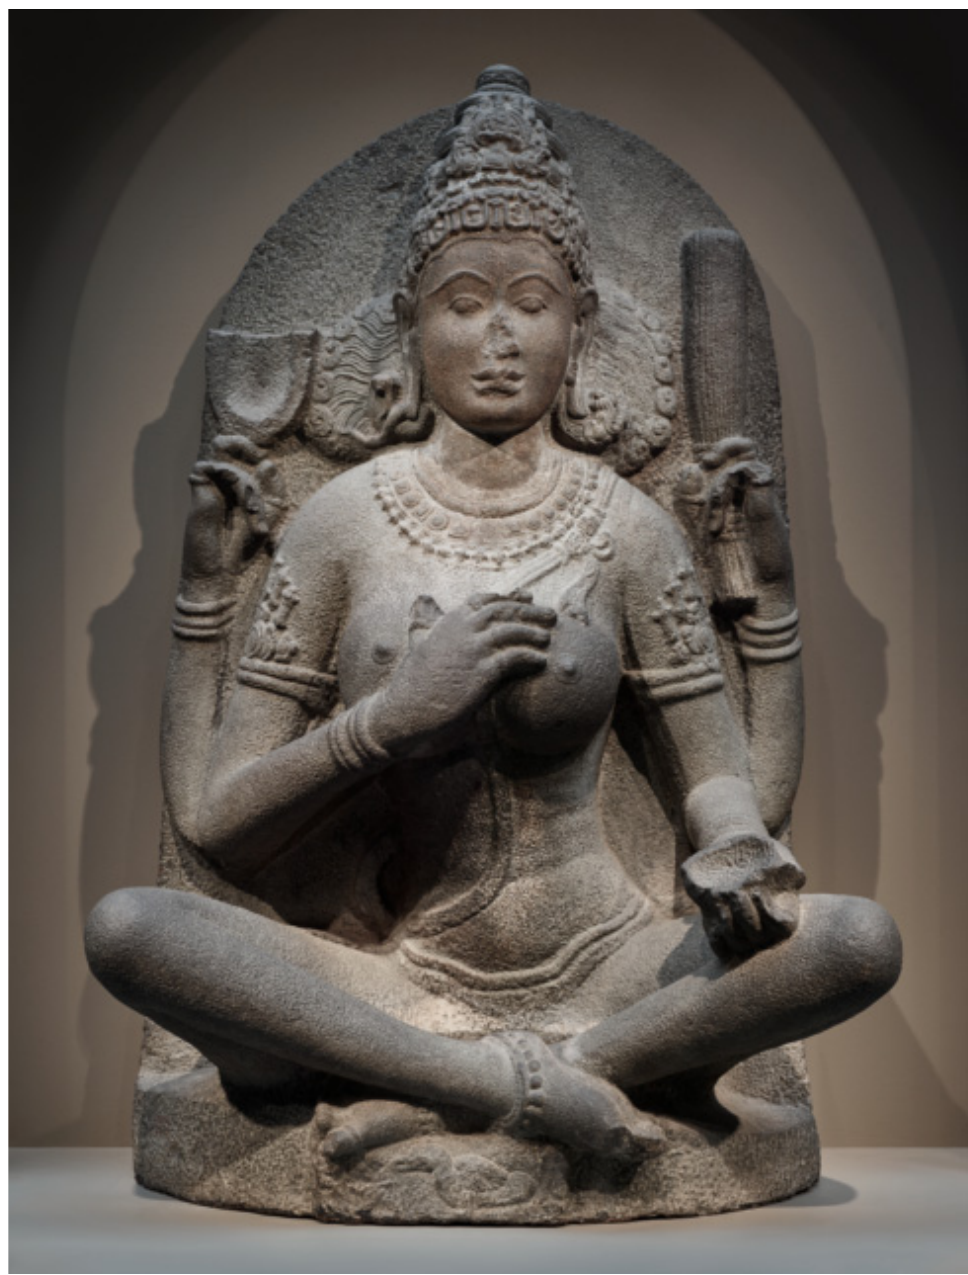
Figure 2. Yogini, Tamil Nadu, late 9th–mid-10th century. 45 11/16 × 29 15/16 × 17 in. (116 × 76 × 43.2 cm). Arthur M. Sackler Gallery, Smithsonian Institution, Washington, DC, Gift of Arthur M. Sackler, S1987.905.